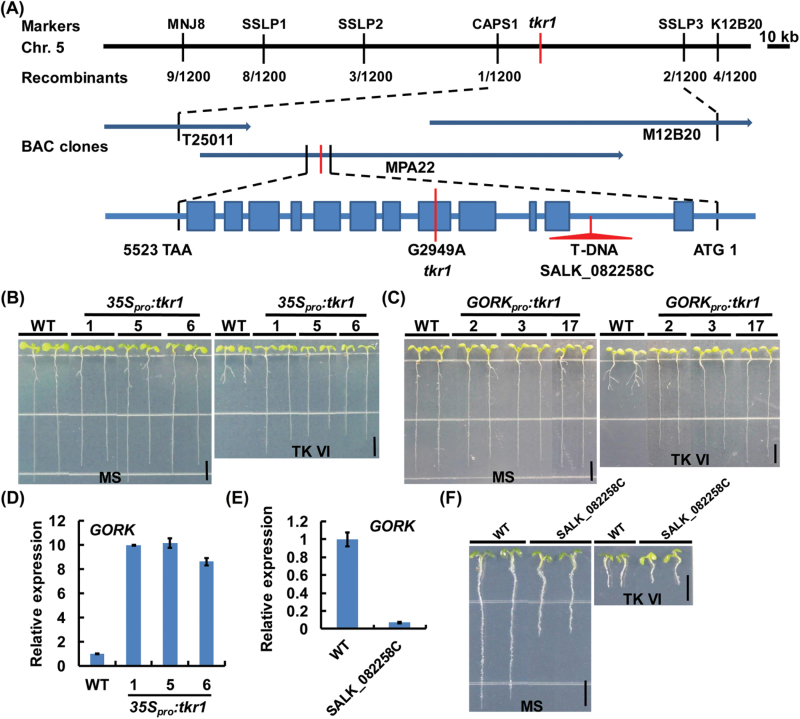
Map-based cloning of the GORK gene. (A) Fine genetic and physical mapping of GORK. The target gene was initially mapped to a genetic interval between the markers MNJ8 and K12B20 on Arabidopsis chromosome 5. The analysis of a mapping population consisting of 1200 plants identified the target gene encoding GORK (At5g37500). In the GORK structure illustration, the filled boxes represent exons and the lines represent introns. Mutation and T-DNA insertion sites are shown in red. (B) Wild-type (WT) and 35S
pro
:tkr1 seedlings grown on medium without (MS) or with 3 μM TK VI at 6 DAG.(C) WT and GORK
pro
:tkr1 seedlings grown on medium without (MS) or with 3 μM TK VI at 6 DAG. (D) qRT–PCR analysis of GORK expression in 35S
pro
:tkr1 seedlings. (E) qRT–PCR analysis of GORK expression in SALK_082258C. For (D) and (E), 10-day-old seedlings were harvested for RNA extraction and qRT–PCR analysis. The transcript level of GORK in the WT was arbitrarily set to 1. The error bars represent the SD of triplicate reactions. (F) WT and SALK_082258C seedlings grown on medium without (MS) or with 3 μM TK VI at 6 DAG. Scale bars=5mm (B, C, F).